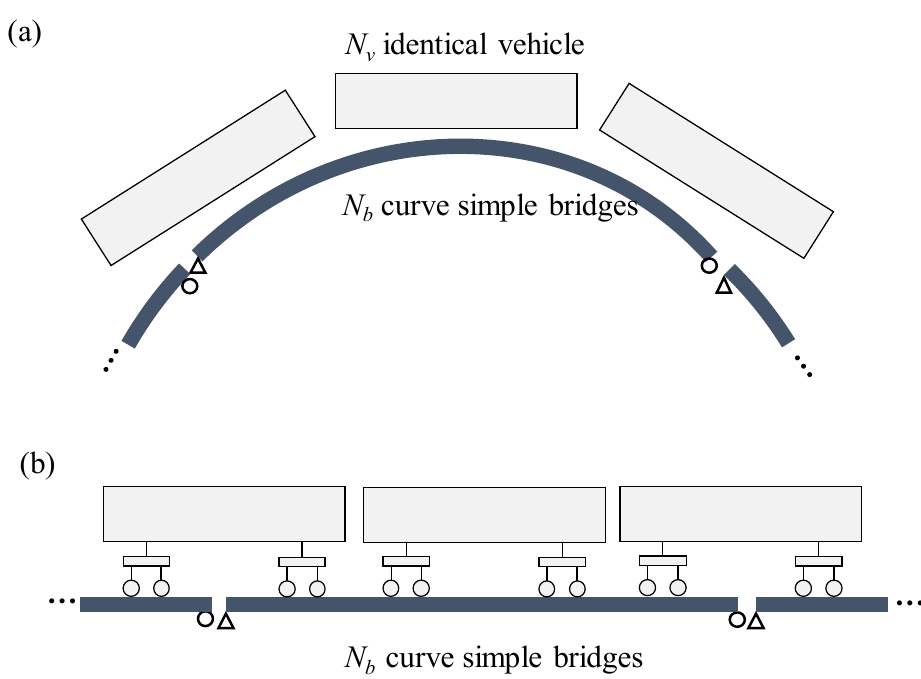
Figure 1. Vehicle bridge system model: ( a ) vertical view; ( b ) side view. Normally, the bridge model can be established by the finite element method (FEM) or the synthetic modal method, and wave and FEM can also be used straightforwardly [31,32]. In this model, the bridge model is developed by the FE method. The bridge adopts a spatial Euler–Bernoulli beam element, and the linear and cubic (Hermitian) shape function is used [33]. Each element node contains six degrees of freedom. Through assembly, the mass matrix M B and stiffness matrix K B of the bridge in the global system can be obtained. The damping C B is assumed to be Rayleigh damping, and it is assumed that the damping ratio of each order is 0.02 [28]. The dynamic equation of the bridge is Equation